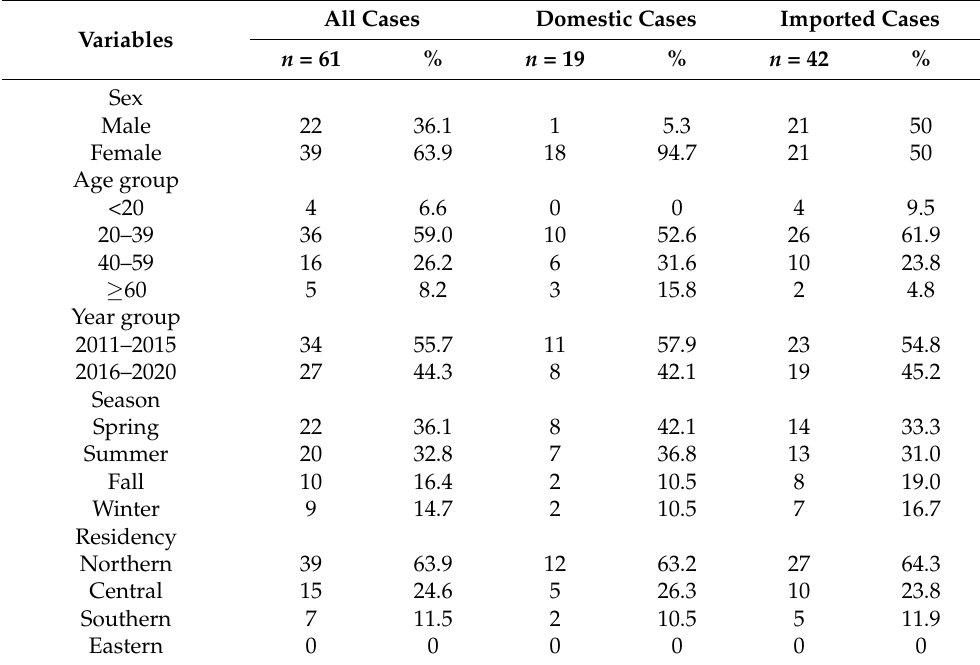
Table 2. Epidemiological features of domestic and imported cases of paratyphoid in Taiwan during